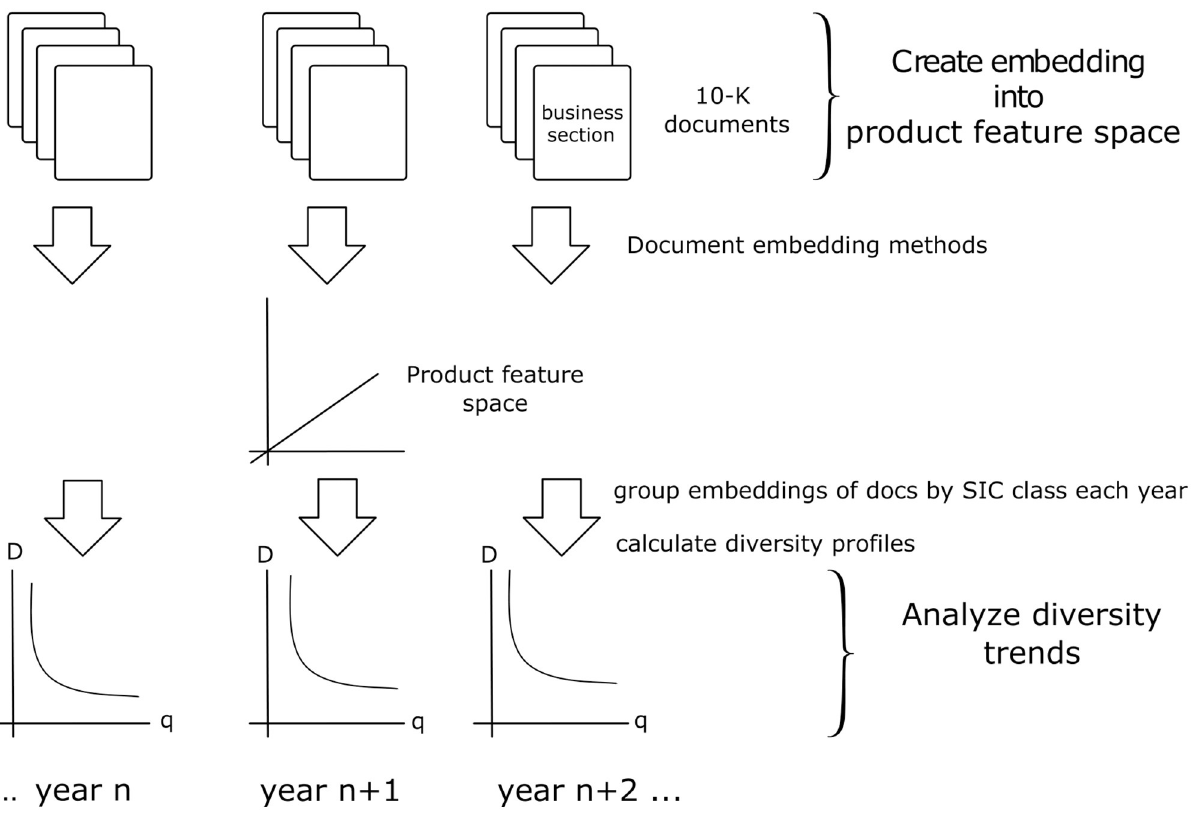
Fig 1. The workflow for a text-based analysis of product